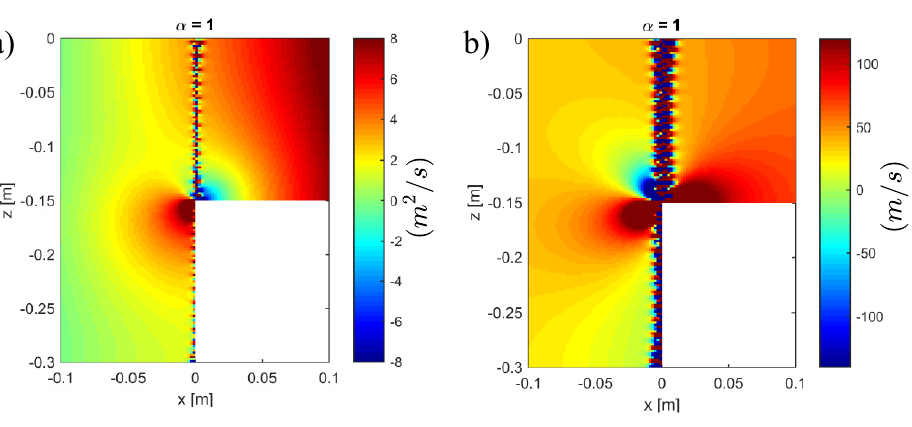
Figure 4. Non-convergent solution of the second-order problem, α = 1 (without truncation of forcing evanescent waves). ( a ) Velocity potential at the second-order φ 2 near the step. ( b ) Horizontal velocity at the second-order ∂ x φ 2 near the